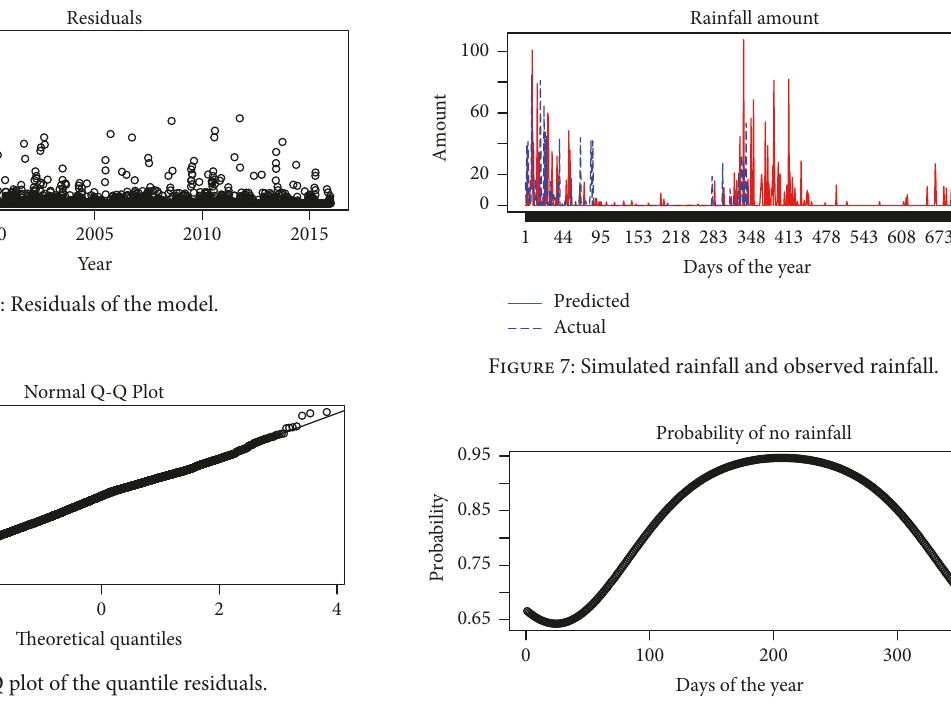
Figure 8: Probability of rainfall